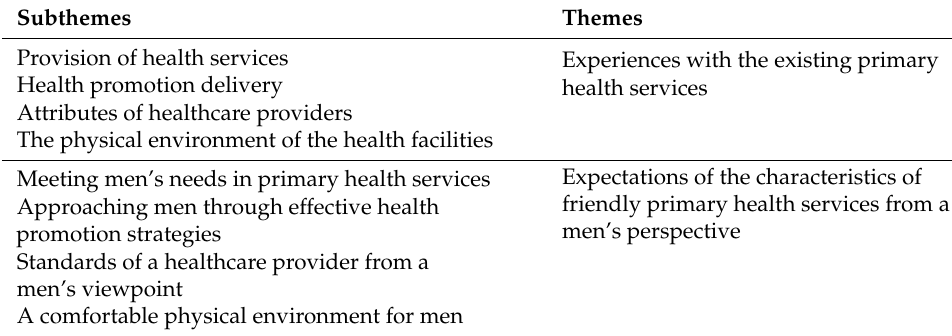
Table 3. The themes and subthemes identified from the thematic